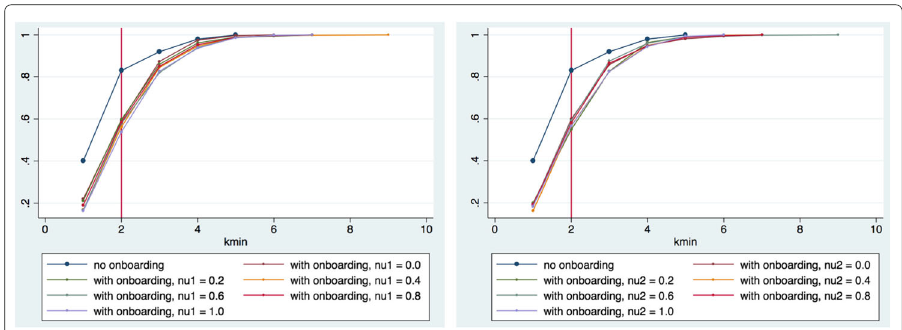
Fig. 4 Cumulate Density Functions of the average value of k min that minimizes the Kolmogorov-Smirnov distance between the in-degree distribution of each interaction network and its best-fit power-law model in the control and treatment groups. Twenty percent of the networks evolved without onboarding ( darkblue ) have degree distributions that test negatively for H1. When onboarding is introduced, that percentage rises to between 50 and 90%. On the left , the treatment group interaction networks have been grouped according to the value taken by ν 1 ; on the right , they have been grouped according to the value taken by ν